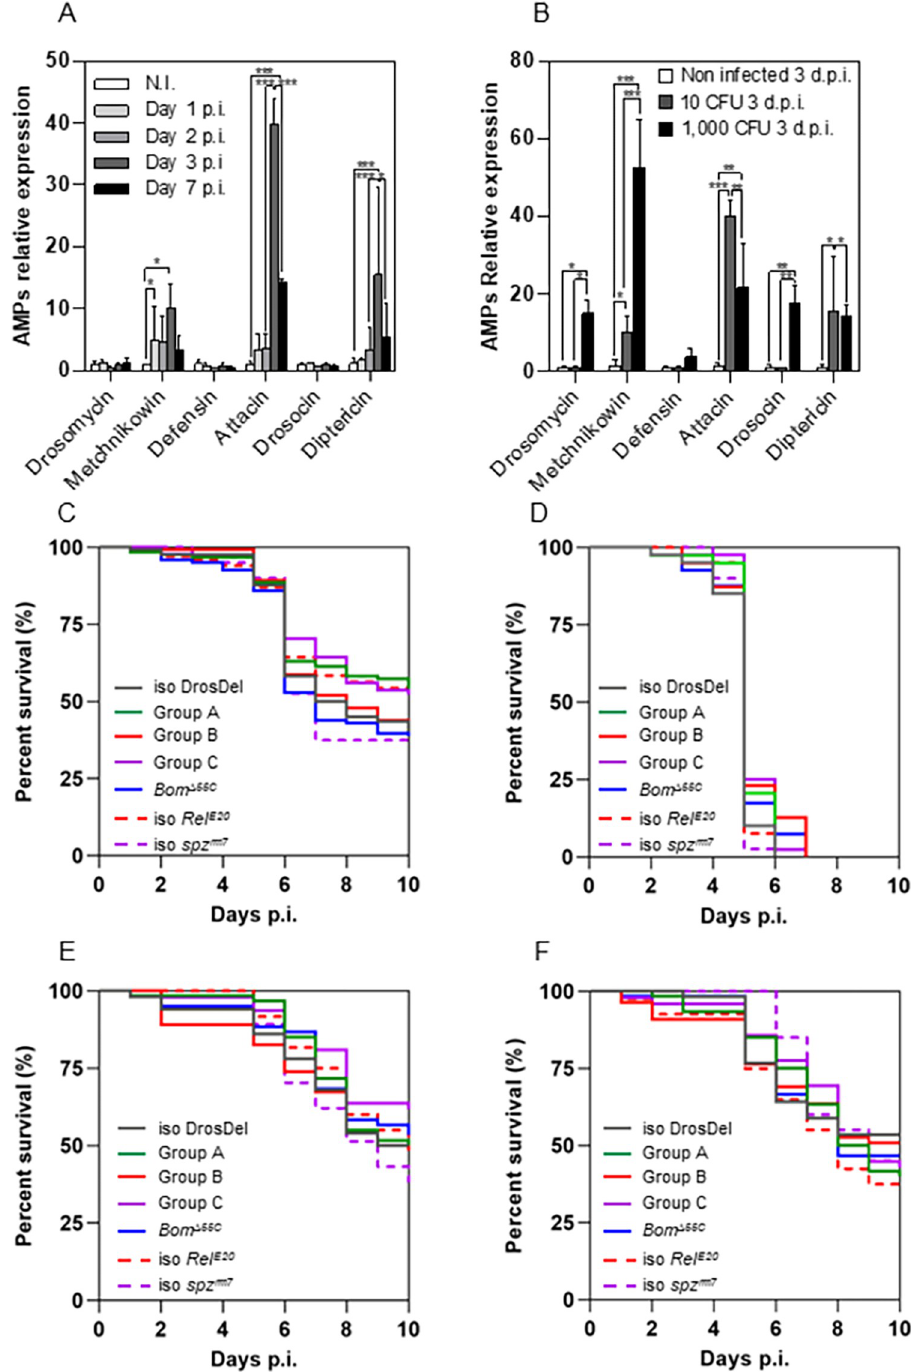
Fig 2. M . abscessus resists the Drosophila AMP response. (A-B) Quantification of relative expression of AMP- encoding genes by qRT-PCR. (A) RNAs were extracted on days 1, 2, 3 and 7 p.i. (post-infection) from w 1118 flies injected with 10 CFU (Colony Forming Unit) (B) RNAs were extracted on day 3 p.i. (post-infection) from w 1118 flies injected with 10 or 1000 CFU. (C-D) Survival curves of w 1118 (iso DrosDel), Defensin (Group A), Attacins - Drosocin - Diptericin (Group B), Drosomycin - Metchnikowin (Group C), Bomanins ( Bom Δ 55C ), Relish (iso Rel E20 ) and spatzle ( spz rm7 ) mutant flies injected with (C) 10 CFU or (D) 1,000 CFU of M . abscessus . (E-F) Survival curves of w 1118 flies injected with (E) 10 CFU of M . abscessus and M . abscessus Δ 0855 or (F) 10 CFU of M . abscessus and M . abscessus Δ 4532 mutant. Histograms represent data from 3 independent experiments performed in triplicate and error bars